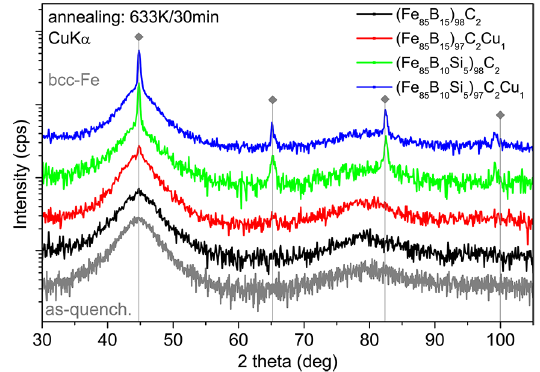
Figure 4. XRD patterns taken from the marked samples in as cast state and after isothermal annealing with interpretation of the diffracted peaks.